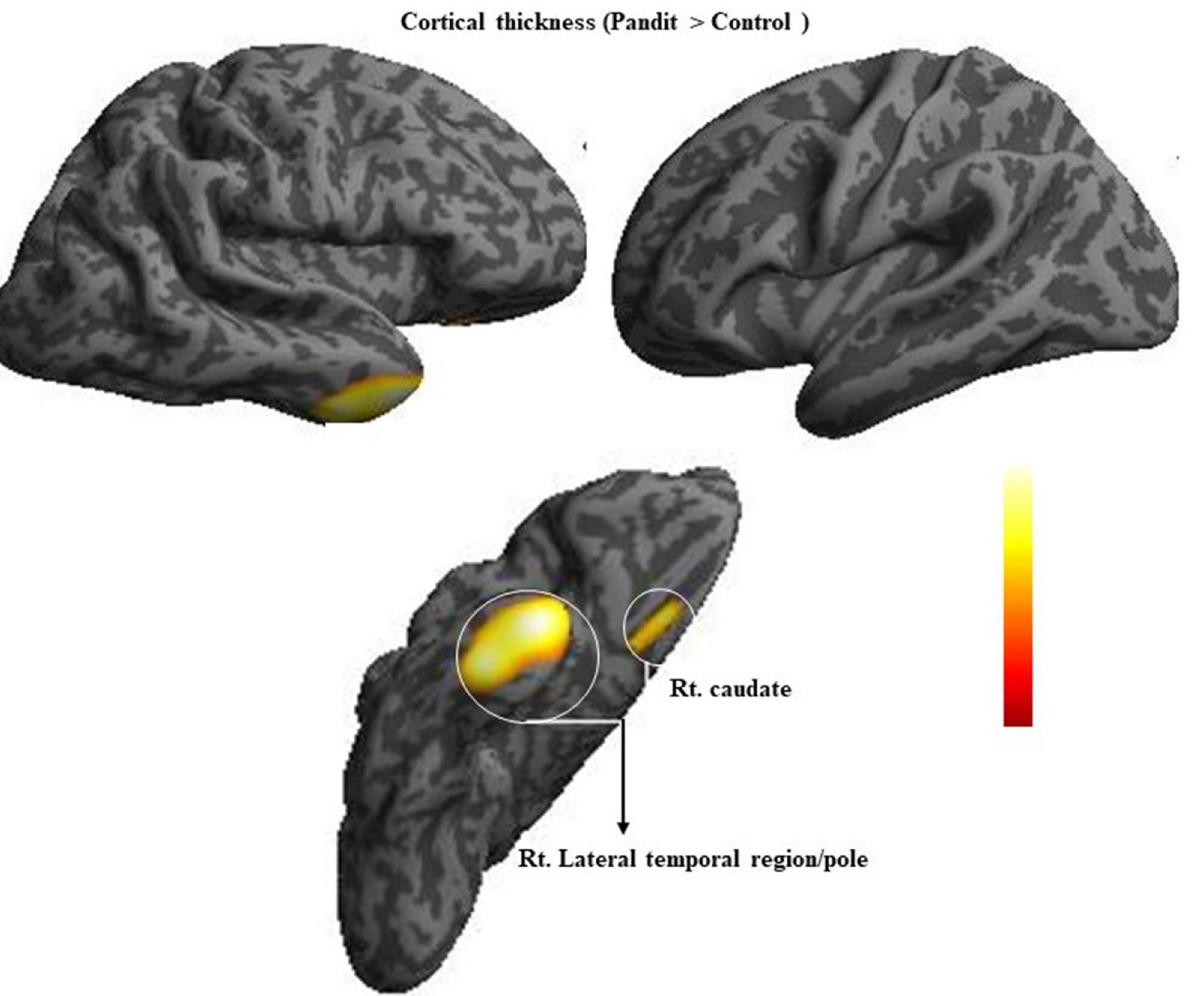
Figure 3. Results of projection based cortical thickness (PBCT) group comparison using computation anatomy toolbox (CAT) rendered on to an inflated cortical surface. The image shows increasedcortical thickness in Pandit/Priest group based on two-sample t -test comparing with control. Thresholded at P < 0.05 (FWE) corrected.